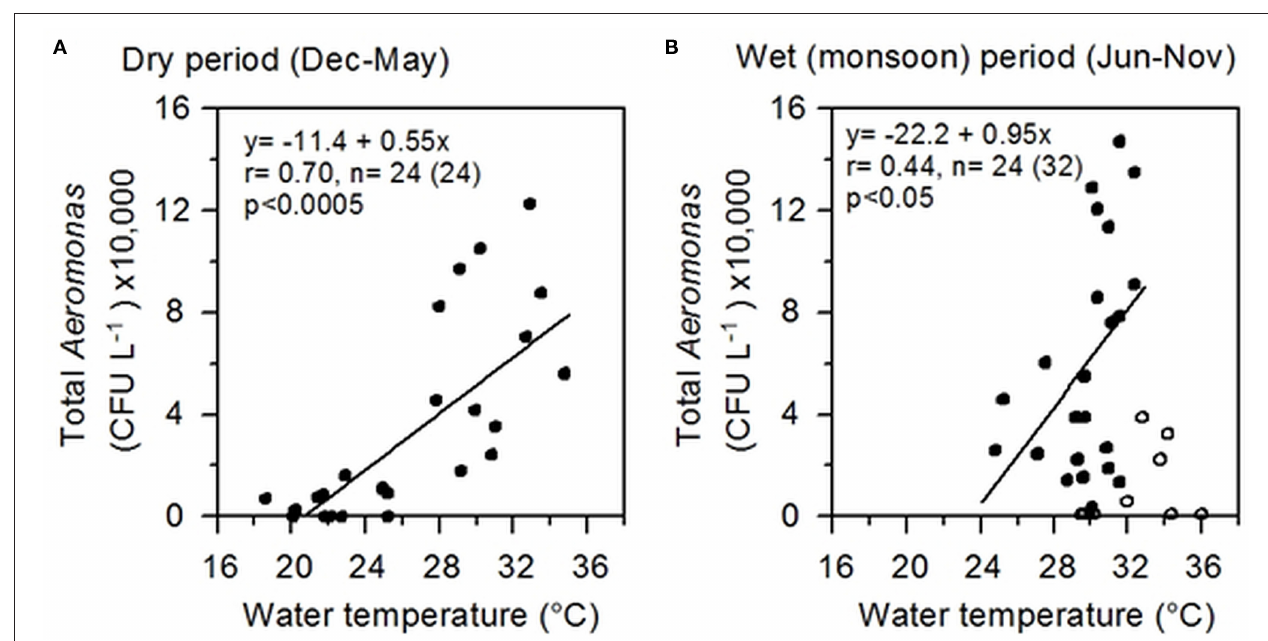
FIGURE 3 | Correlation between Aeromonas abundance and water temperature. (A) Correlation during the dry period (December to May); (B) Correlation during the wet period (June to November), excluding eight outliers. Lines represent linear regressions; relevant information including regression equation, “r” and “p” values are shown inside each box. Correlating data are shown as filled circles (dots) and the outliers as empty circles.